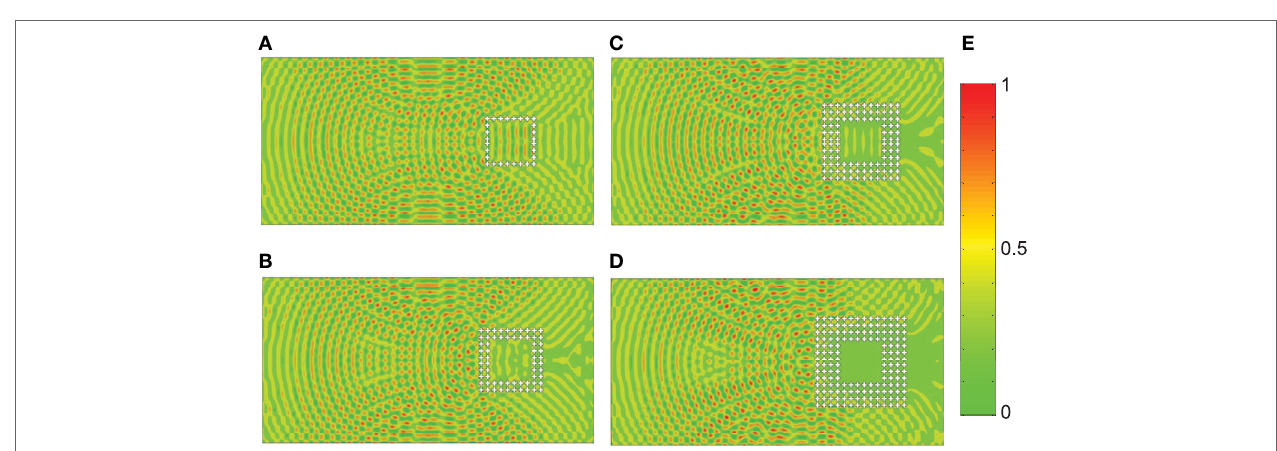
FigUre 8 | Von Mises stress for the phononic plate with (a) 1 row, (B) 2 rows, (c) 3 rows, and (D) 4 rows. Displacement fields are recorded at 780 µs from the excitation time. (e) Colors from green to red denote zero and maximum stress,